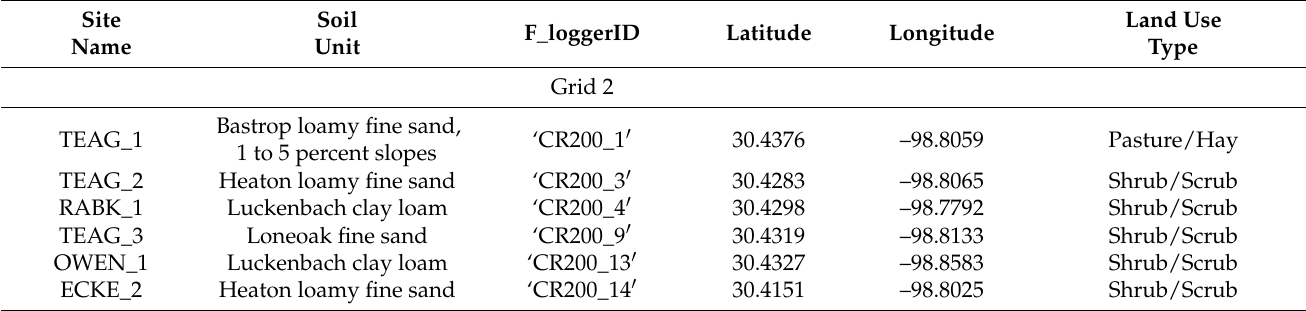
Table 1. TxSON Stations within the Study Area.